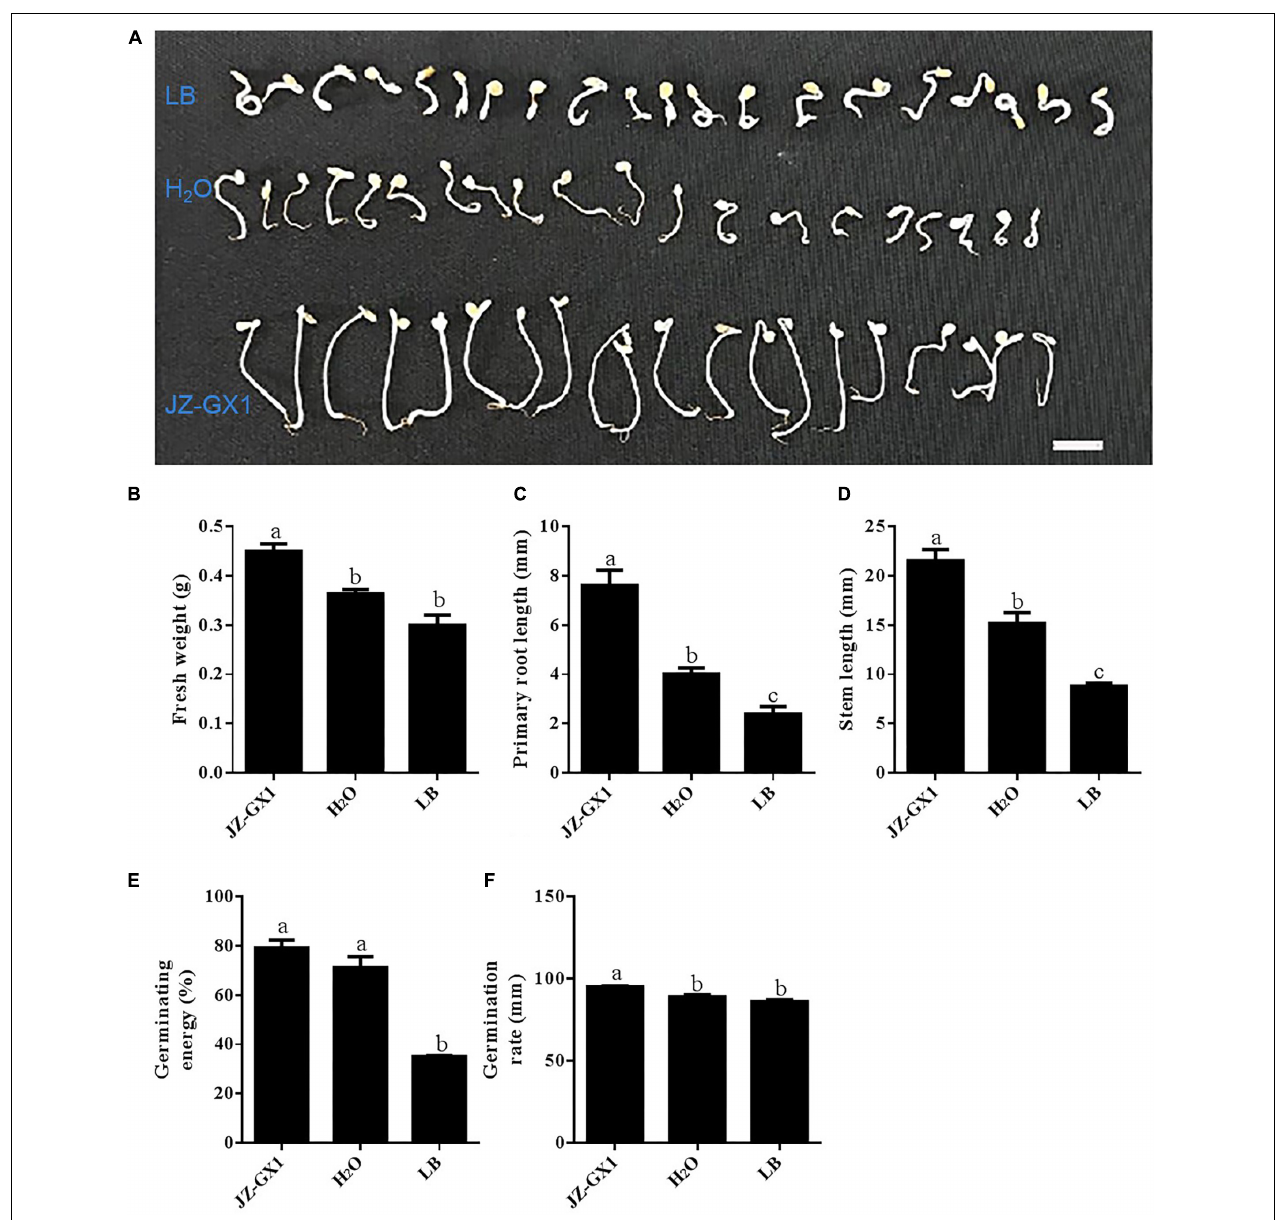
FIGURE 8 | Effects of R. aquatilis JZ-GX1 on tomato seed germination and seedling growth under salt stress (100 mM). (A) Phenotype. (B) Fresh weight. (C) Primary root length. (D) Stem length. (E) Germination energy. (F) Germination rate. The vertical bars represent the standard deviations of the averages. One-way ANOVA was performed, and Duncan’s post hoc test was applied. Different letters indicate significant differences ( P < 0.05) among the treatments.